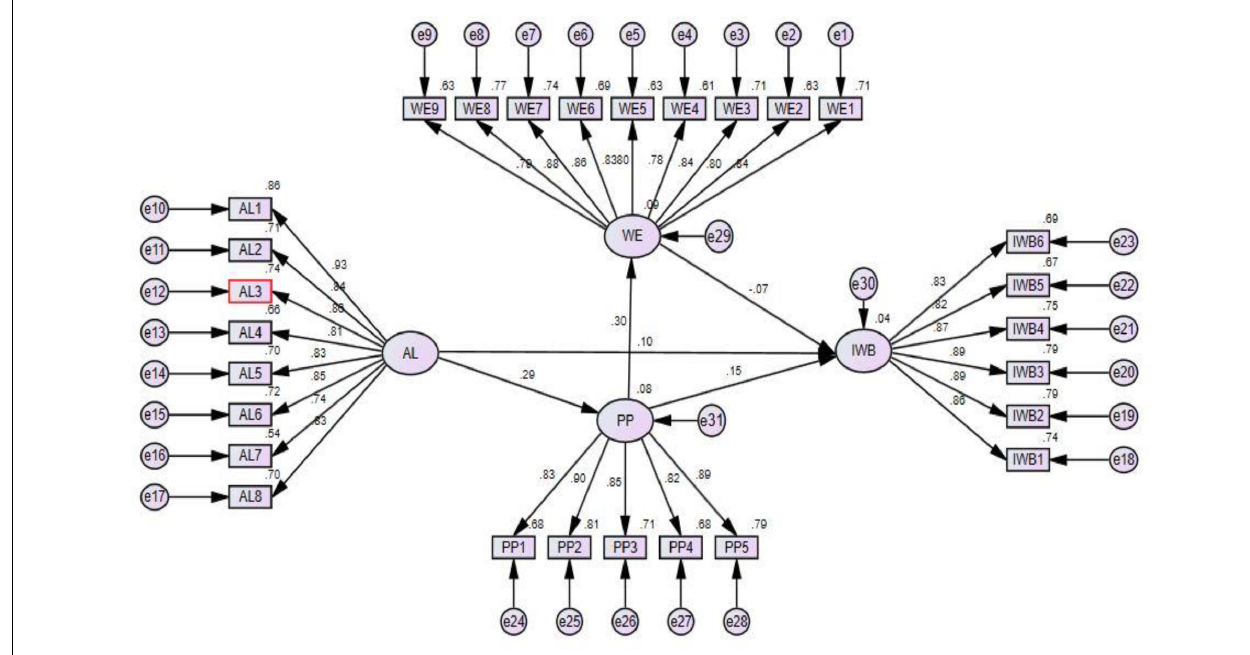
FIGURE 2 | Structural